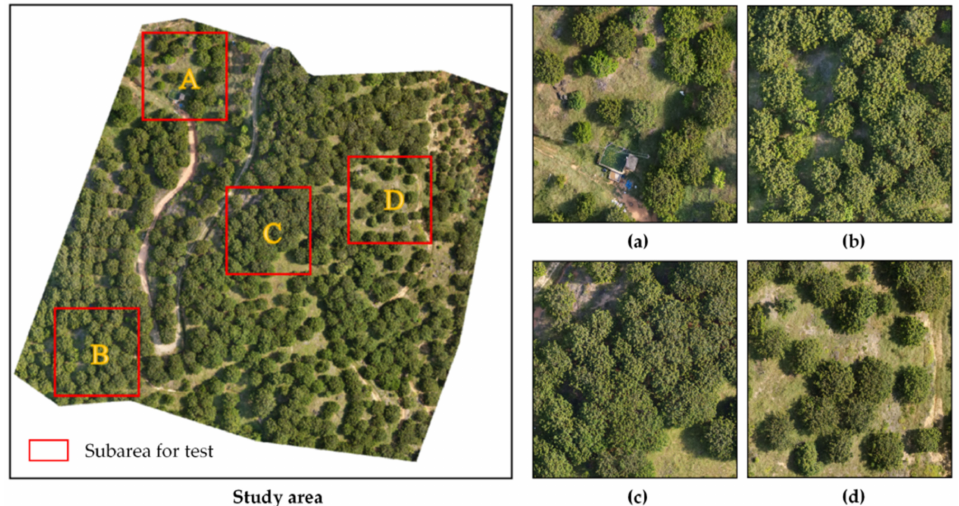
Figure 6. Location of the four test subareas (A–D): ( a – d ) details of olive trees in the A–D test subareas,